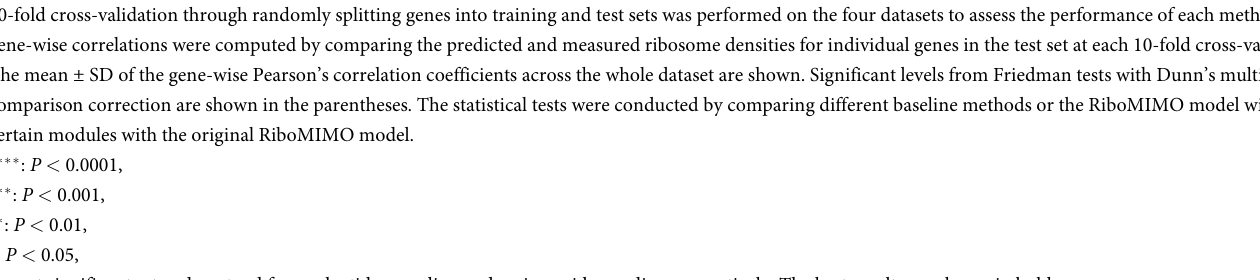
10-fold cross-validation through randomly splitting genes into training and test sets was performed on the four datasets to assess the performance of each method. The gene-wise correlations were computed by comparing the predicted and measured ribosome densities for individual genes in the test set at each 10-fold cross-validation. The mean ± SD of the gene-wise Pearson’s correlation coefficients across the whole dataset are shown. Significant levels from Friedman tests with Dunn’s multiple comparison correction are shown in the parentheses. The statistical tests were conducted by comparing different baseline methods or the RiboMIMO model without certain modules with the original RiboMIMO model.